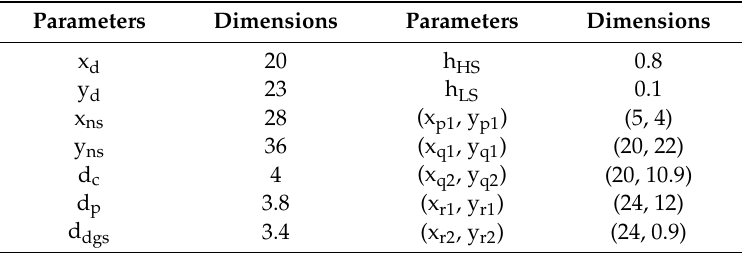
Table 1. Design parameters and dimensions (units: mm).